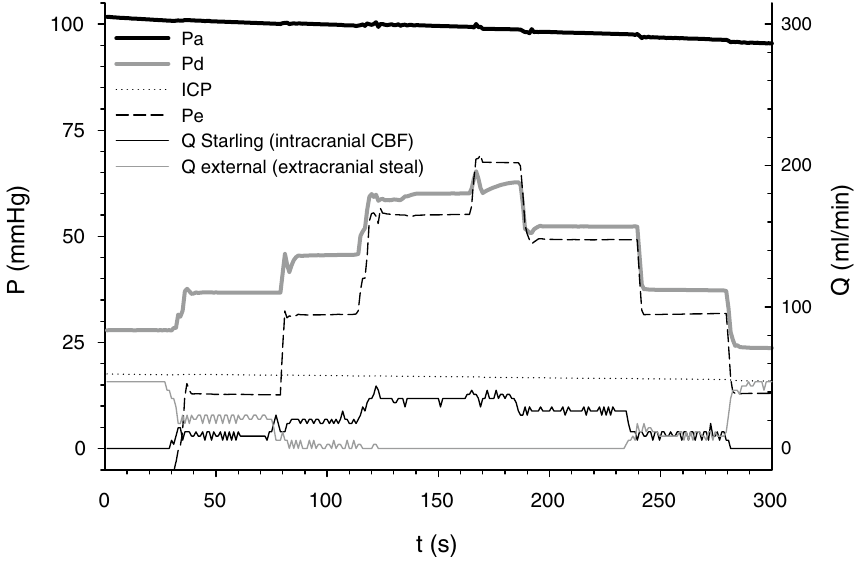
Figure 3. Bench simulation of the intra-extracranial flow diversion with increased intracranial pressure: Fluid from the irrigation set with pressure Pa is flowing through the Starling resistor with pressure ICP and external pathway with outflow pressure Pe. Flow is measured with the rotary flowmeters, where flow Q Starling represents CBF in the intracranial compartment and is zero at the start of measurement. Roller clamp before the bifurcation creates fixed inflow resistance with the pressure Pd, distal to it. As outflow pressure in the external bypass pathway Pe is increased by raising the height of the outflow, flow Q external decreases, and Pd increases, reestablishing Q Starling due to the steal reversal. Maximal flow in the Starling resistor coincides with the cessation of flow in the bypass pathway and with maximization of Pd: Rising Pe beyond this point does not increase Pd and does not increase flow through the Starling resistor. Lowering Pe again, induces flow diversion from the Starling resistor, thus simulating intra-extracranial steal: which depends—as shown—from ICP–Pe (outflow pressure) gradient, and thus is reversible by increased Pe.